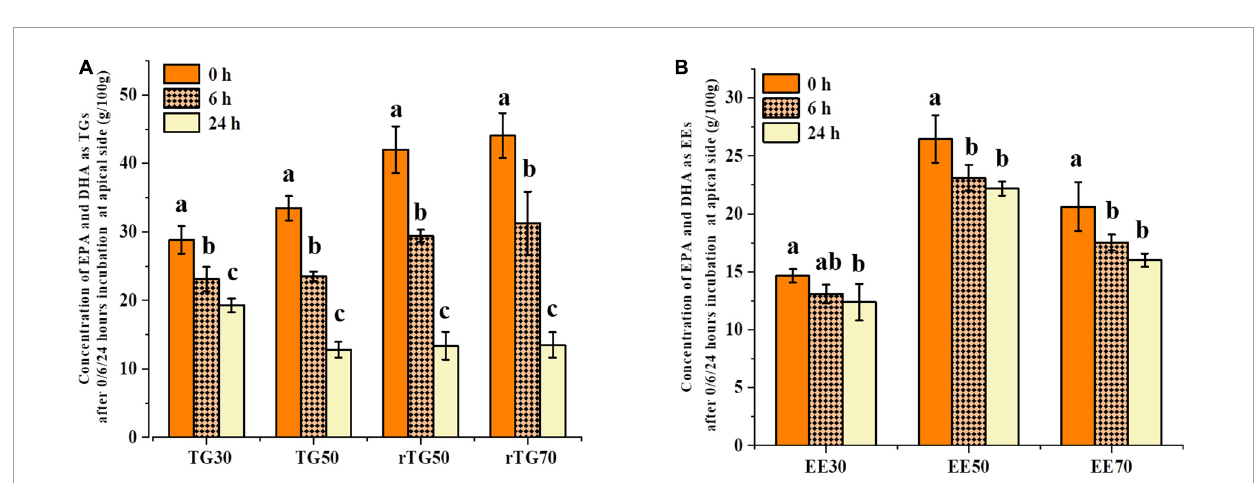
FIGURE5 Concentrations of EPA/DHA as (A) TGs and (B) EEs on the apical side after 0, 6, and 24 h transport. Data represents mean ± SD ( n = 3). Different letters (a, b, and c) indicate statistically significant differences among different groups by ANOVA ( p <